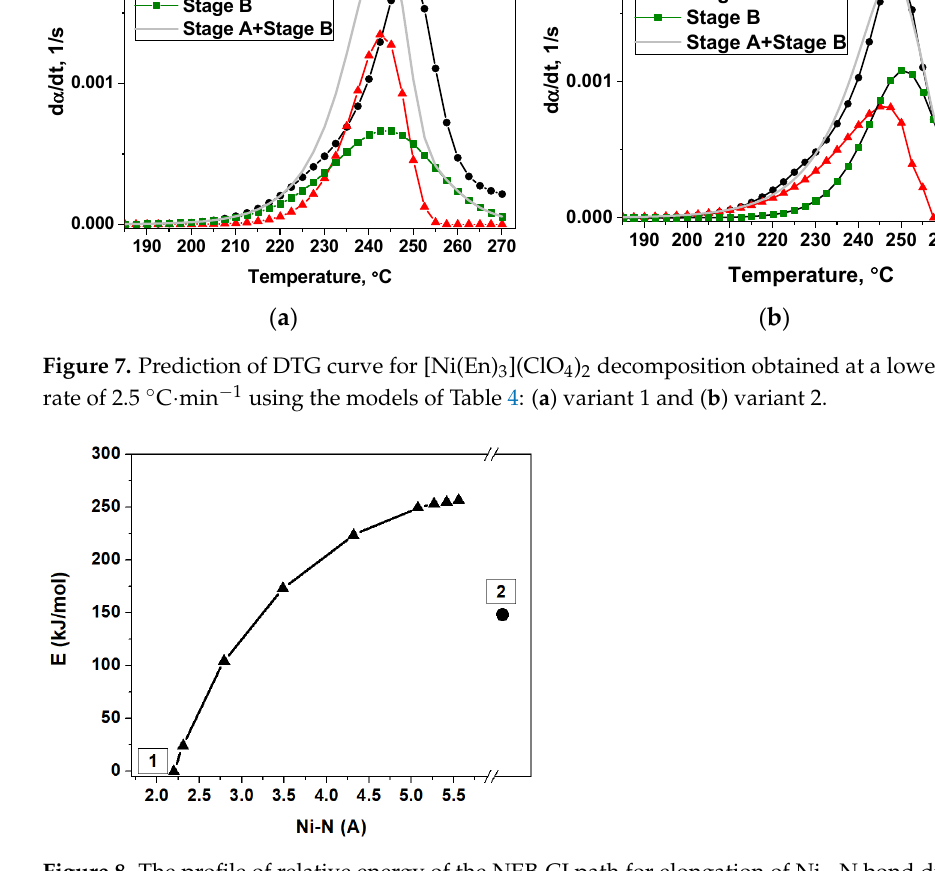
Figure 8. The profile of relative energy of the NEB-CI path for elongation of Ni − N bond during the elimination of one En molecule from [Ni(En) 3 ] 2+ , where 1 is the initial [Ni(En) 3 ] 2+ state and 2 is fully optimized [Ni(En) 2 ] 2+ + En system.